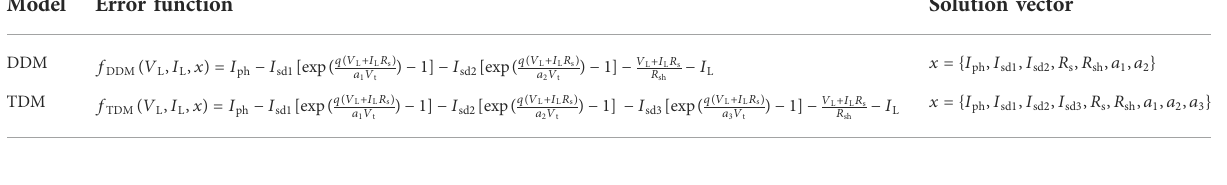
TABLE 1 Error functions of DDM and TDM.